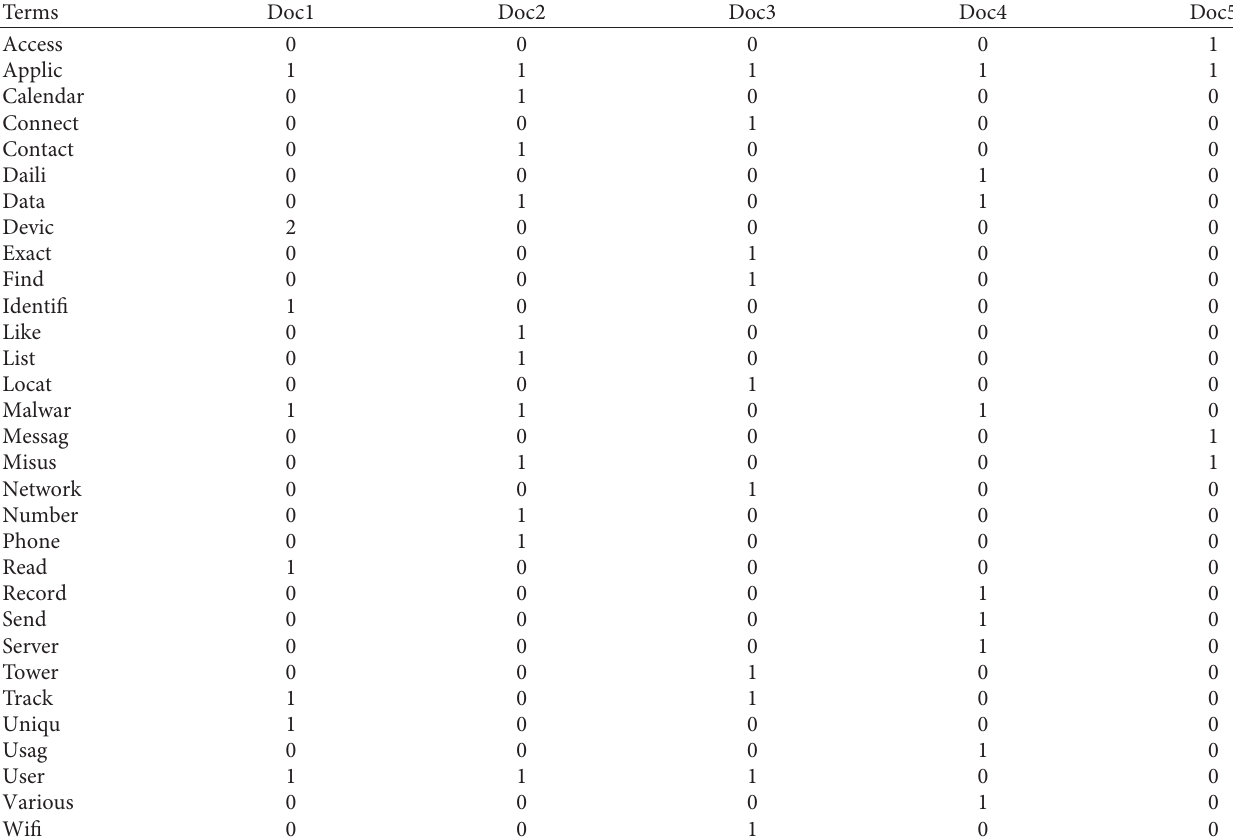
Table 3: Document-term matrix describing frequency of terms.